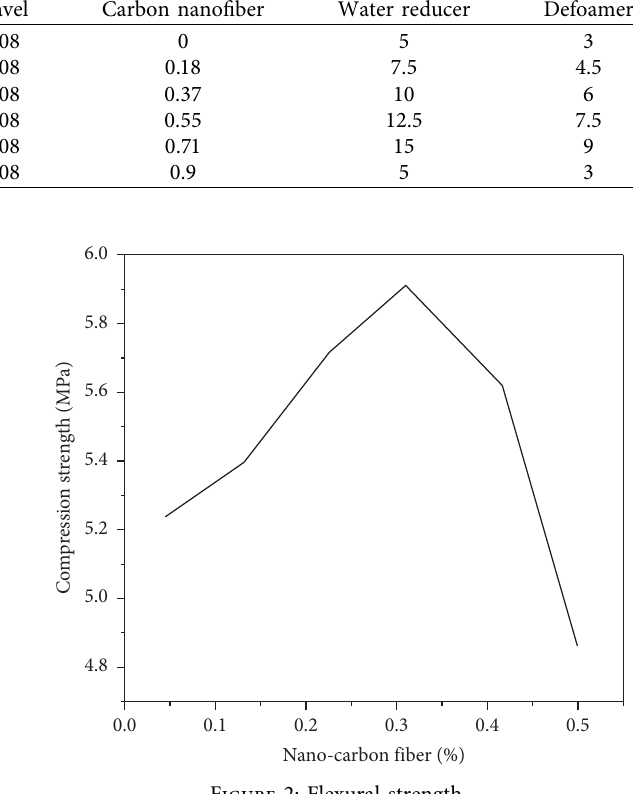
Figure 2: Flexural